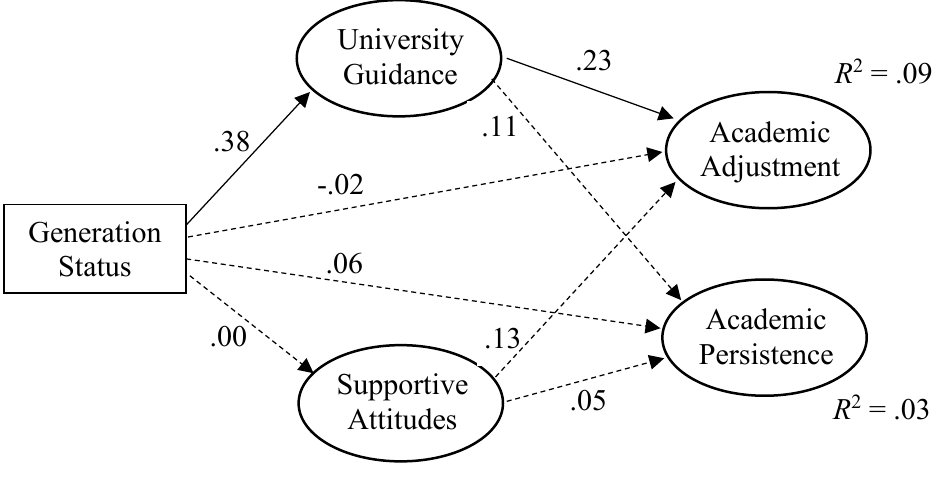
Structural Equation Model (SEM) of Family Resources and Academic Outcomes